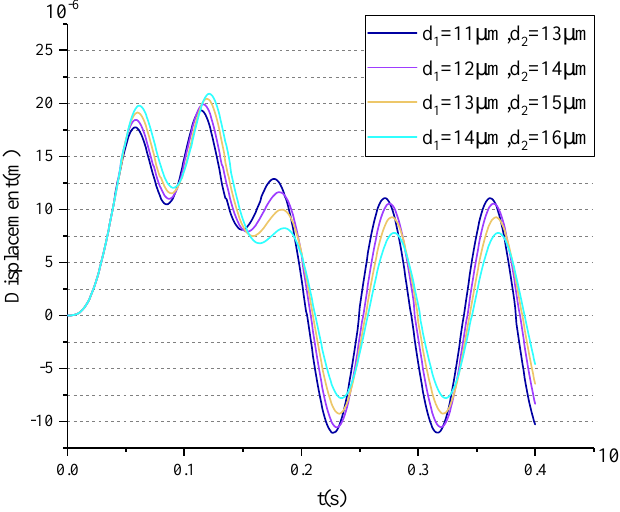
Figure 10. The results of the Simulink model of the shock response of the MEMS gyroscope under different d 1 and d 2